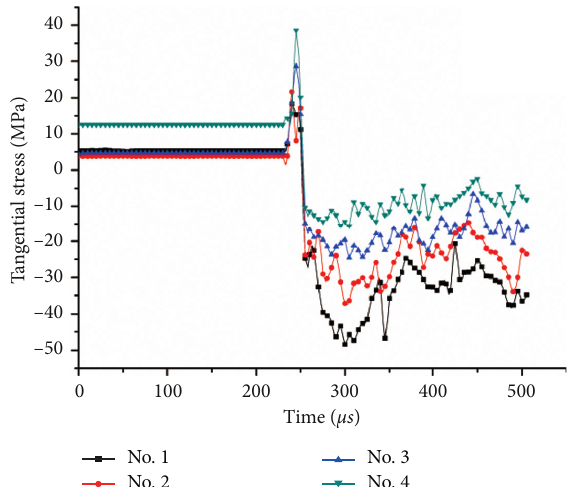
Figure 7: Curves of changes in stress at calculated points under the action of the combined stress field.